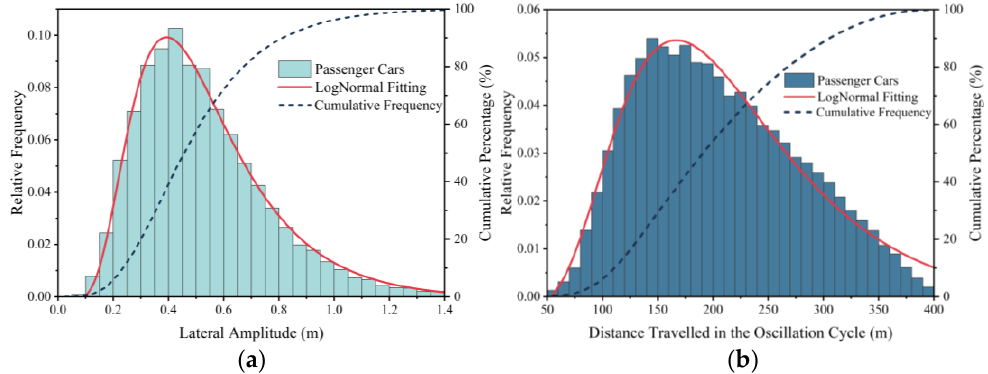
Figure 7. ( a ) Distribution of the LA for passenger cars; ( b ) Distribution of the DTOC for passenger cars.